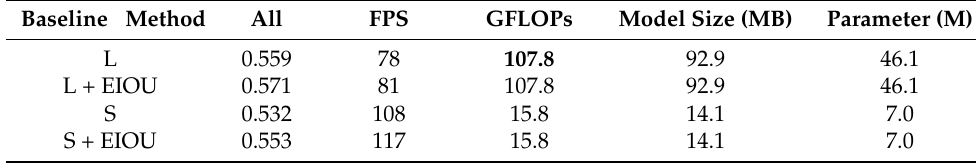
Table 3. Loss function improvement case parameters on the BDP dataset (batch =